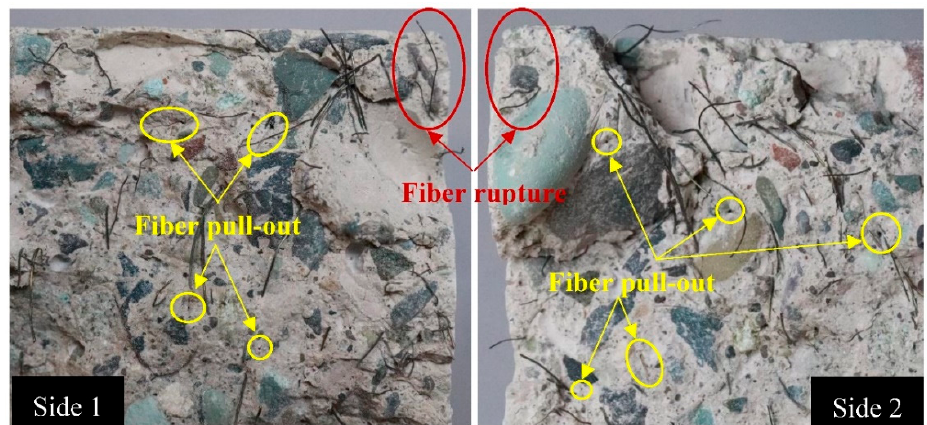
Figure 10. Impact of RTSF dosage on the toughness indices and residual strength factors of FR- AASCs.